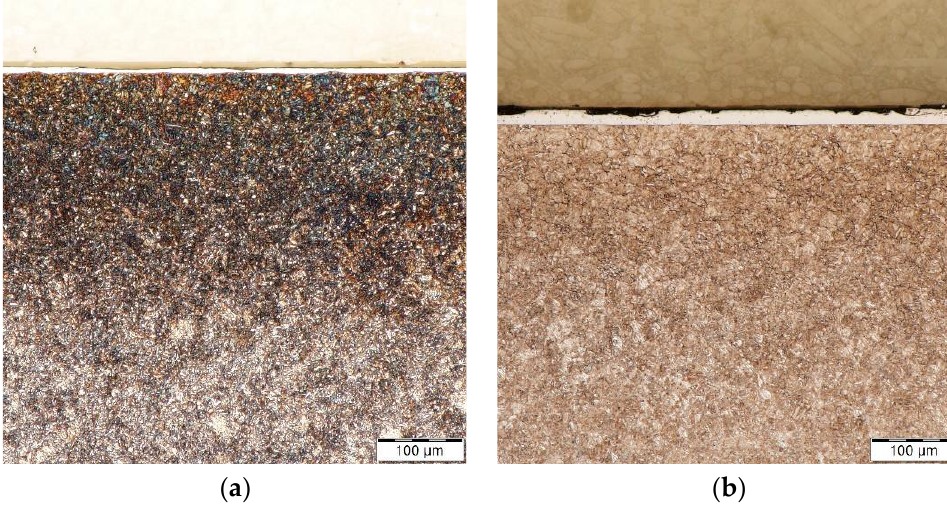
Figure 2. Microstructure of cross-sections of samples after nitriding: ( a ) in plasma; ( b ) in a gas.